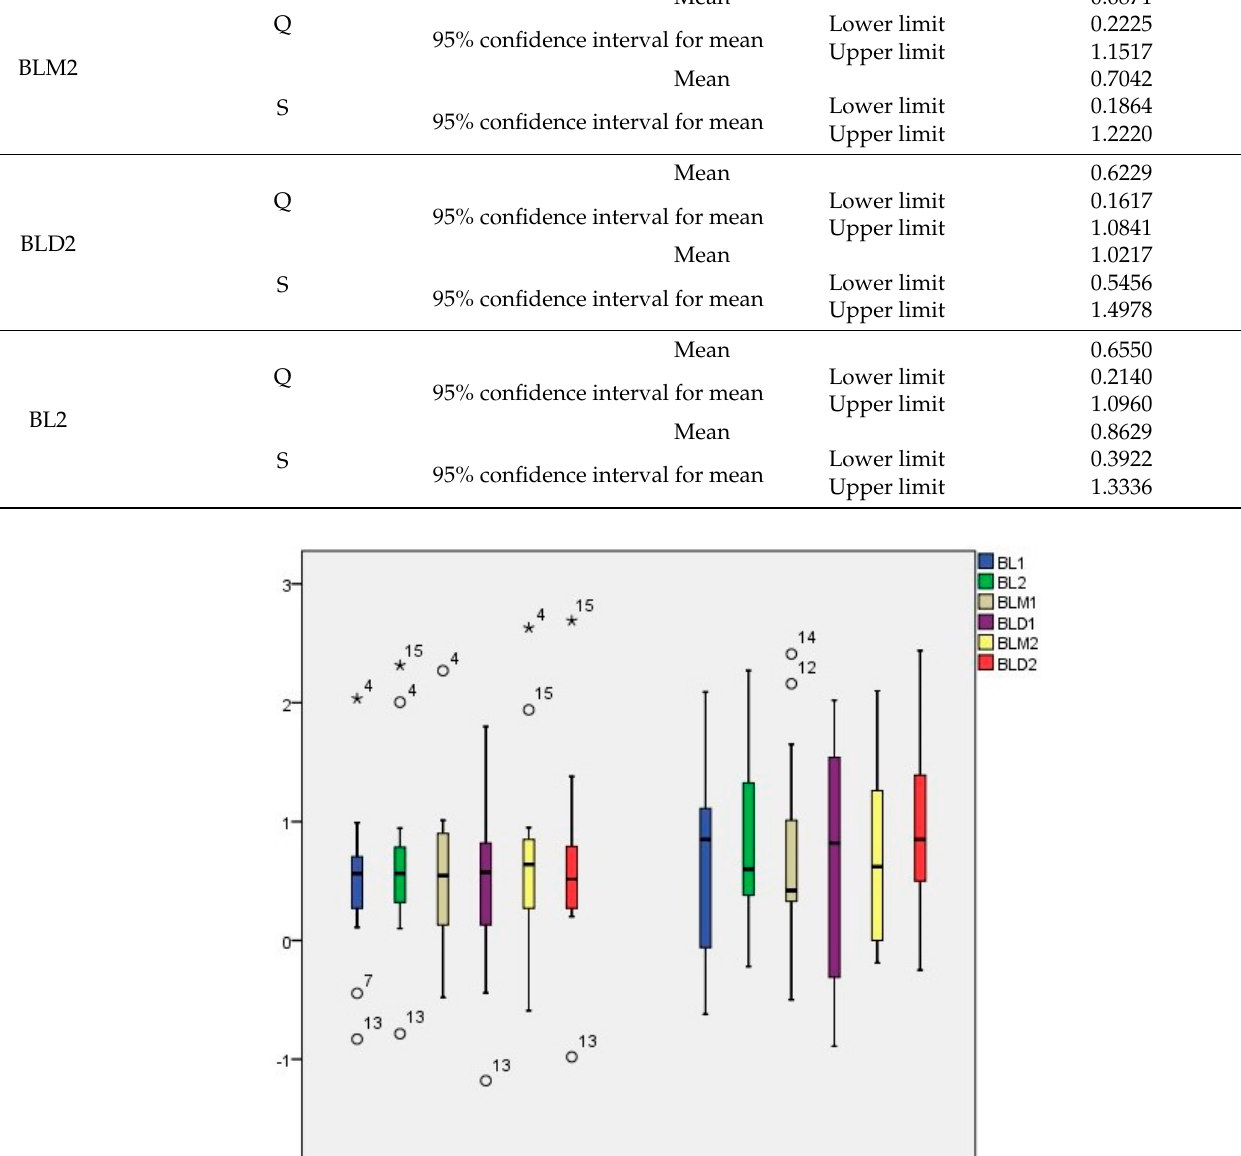
Table 1. Bone level values for the two implants at the time of loading (3 months after insertion and 5 years after insertion). BLM1, mesial bone level at 3 months; BLD1, distal bone level at 3 months; BL1, mid-bone level at 3 months (BLM1 + BLD1/2). S = Standard implant, Q = Quattro implant. Table 2. Bone level values for the two implants at 5 years after loading. BLM2, mesial bone level at 5 years; BLD2, distal bone level at 5 years; BL2, mid-bone level at 5 years (BLM2 + BLD2/2). S = Standard implant, Q = Quattro implant.